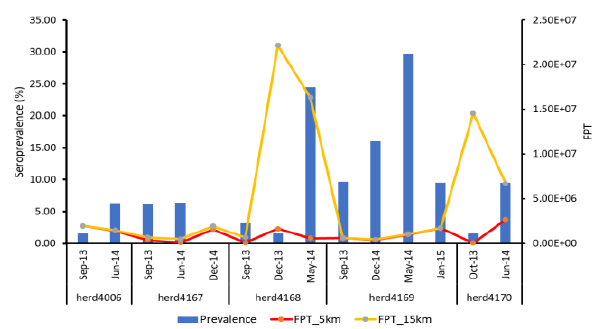
Figure 4 : Relationship between RVFV serology survey and intensity of space use at the time of sampling. The movements of herds and seroprevalence were measured in Isiolo County (herd4006, herd4167 and herd4170) and Tana River County (herd4168 and herd4169), Kenya. High first passage time (FPT) alludes to intensely used space while low values indicate transient